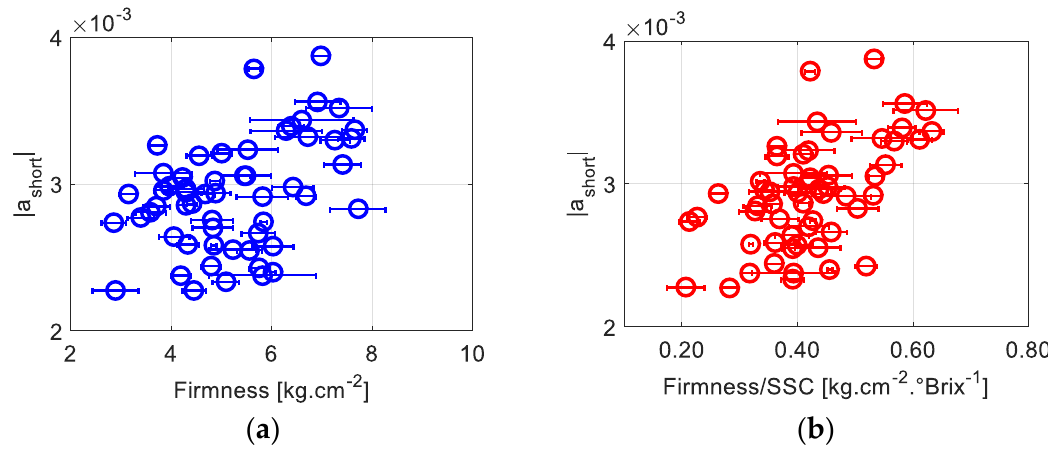
Figure 5. The speed of contrast degradation at short exposure durations | a short | as a function of the firmness ( a ) and ( b ) the ratio of the firmness to the soluble solids content (SSC). Horizontal error bars correspond to standard deviations of three different performed firmness measurements.